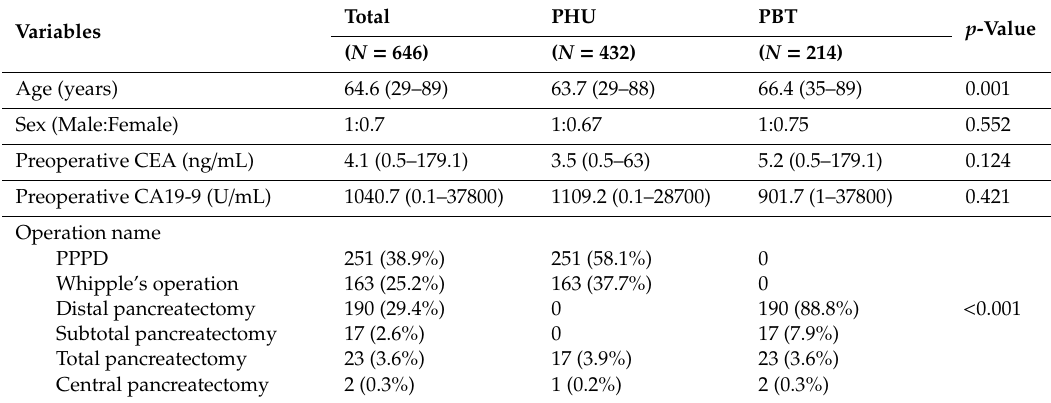
Table 2. Demographics and clinicopathological features of resected patients.